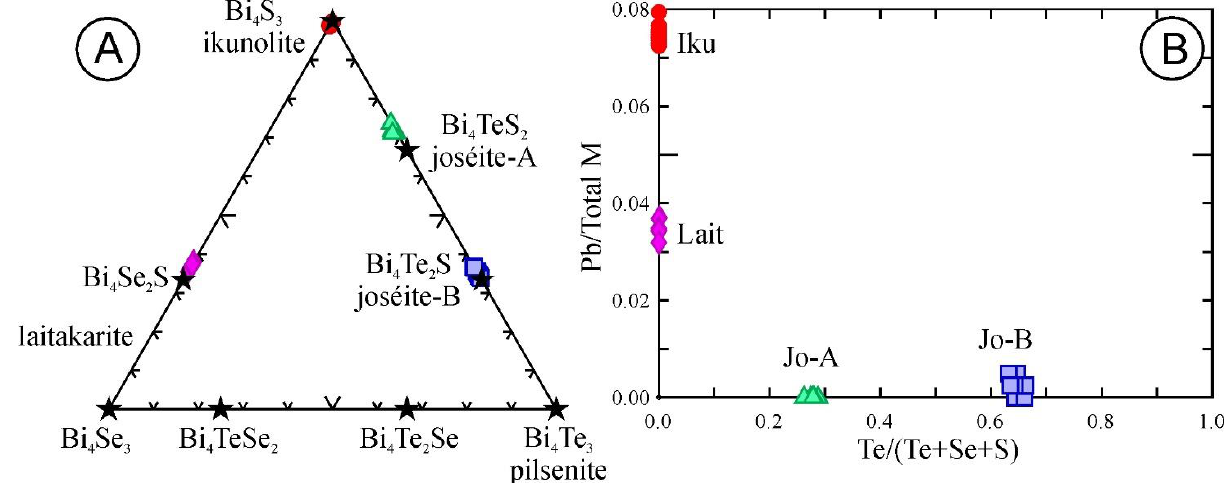
Figure 4. Representation of compositional data for Bi 4 X 3 phases. ( A ) Bi 4 S 3- Bi 4 Se 3 –Bi 4 Te 3 ternary diagram. ( B ) Plot of Pb/total metals vs. Te/(Te+Se+S). Iku–ikunolite, Lait–laitakarite, Jo-A–joséite-A, Jo-B–joséite-B.